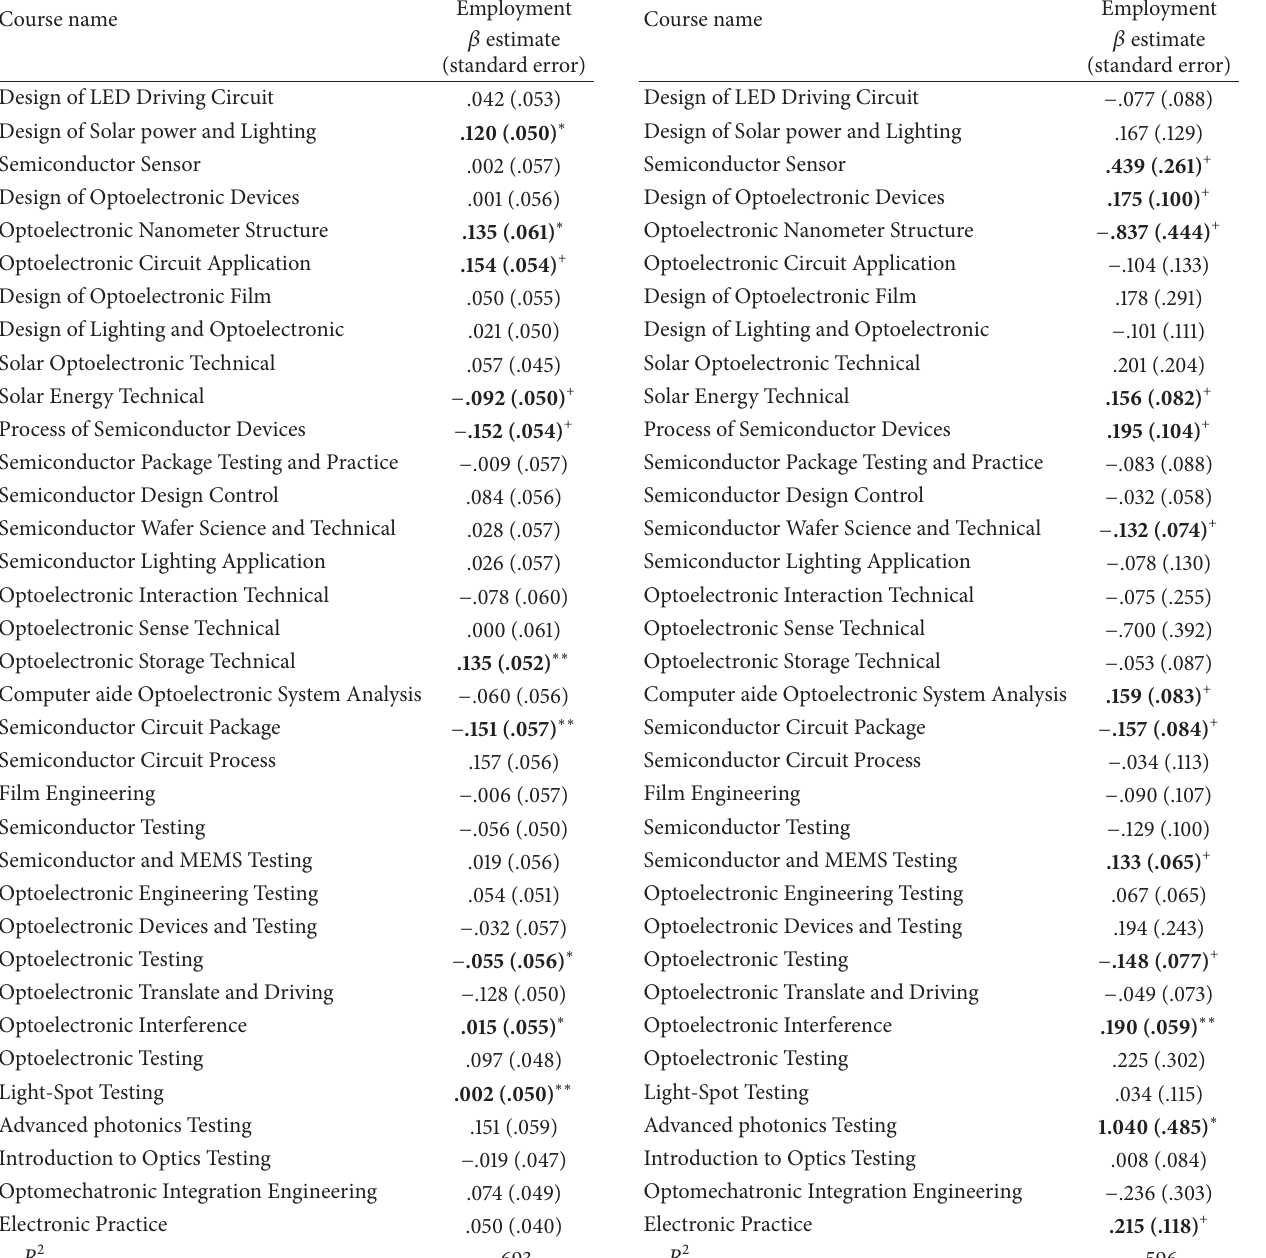
Table 12: Multiple regression analysis—skill-based curriculum on employability (university sample).